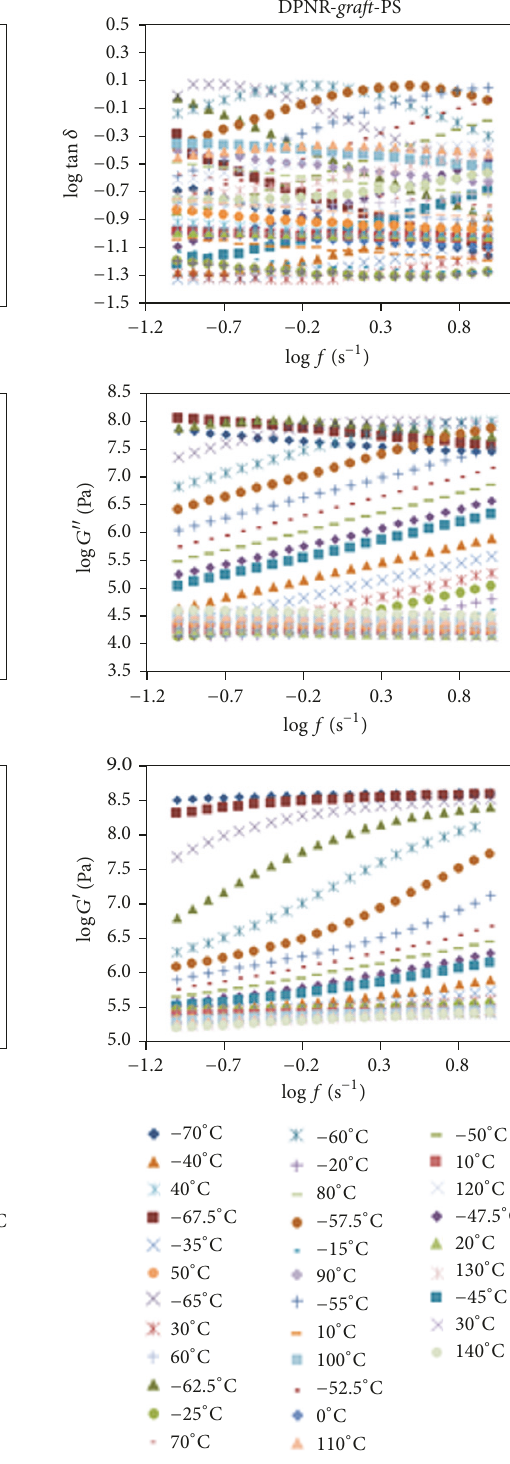
Figure 5: Frequency sweep curves at various temperatures of DPNR and DPNR- graft